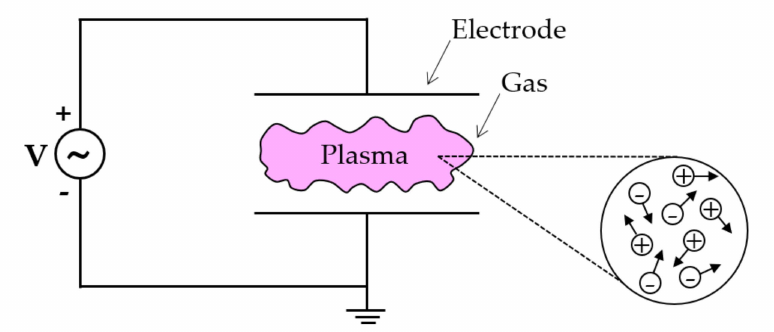
Figure 2. Schematic view of a plasma discharge between two electrodes connected to a voltage source. Plasma is a macroscopically neutral and conductive ionized gas constituted of a mixture of particles moving in all